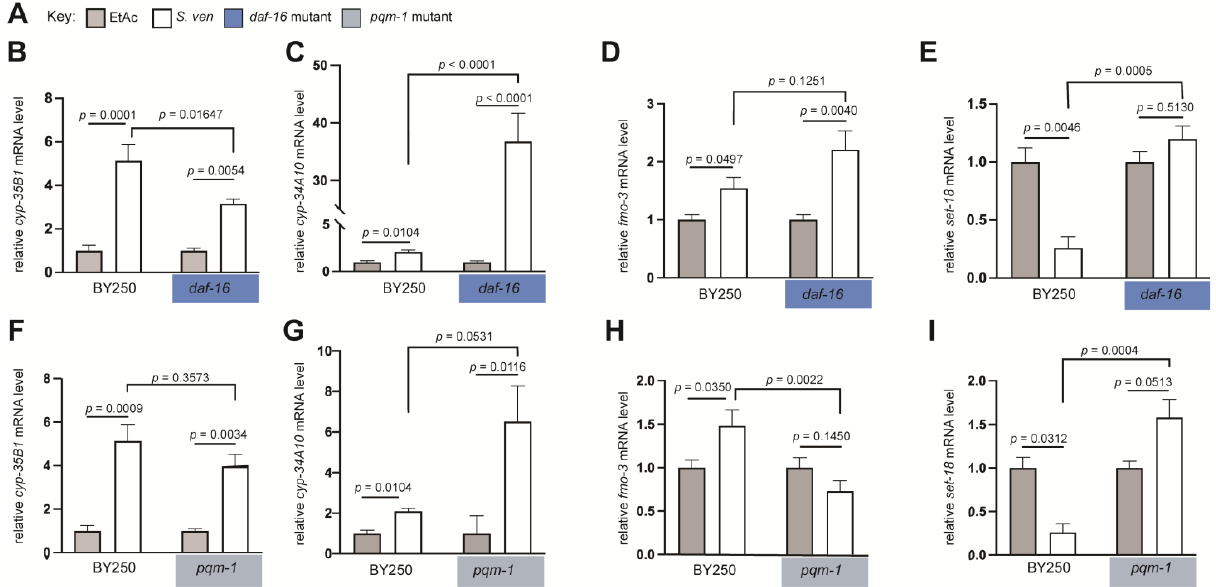
Figure 3. DEGs modulated by daf - 16 and pqm - 1 in response to S. ven metabolite. Quantification of relative mRNA expression levels of genes containing DAF-16 regulatory motifs was measured in daf - 16 (dark blue background) or pqm - 1 (light blue background) mutants following exposure to S. ven metabolite or EtAc treatments. ( A ) Key indicating gray bars represent EtAc exposure, and white bars represent S. ven exposure; dark blue boxes represent daf - 16 mutants and light blue boxes represent pqm - 1 mutants. ( B ) cyp - 35B1 mRNA expression was measured in day 7 BY250 and daf-16 mutant adult worms. ( C ) cyp - 34A10 mRNA expression was measured in day 7 BY250 and daf-16 mutant adult worms. ( D ) fmo - 3 mRNA expression was measured in day 7 BY250 and daf-16 mutant adult worms. ( E ) set - 18 mRNA expression was measured in day 7 BY250 and daf - 16 mutant adult worms. ( F ) cyp - 35B1 mRNA expression was measured in day 7 BY250 and pqm - 1 mutant adult worms. ( G ) cyp - 34A10 mRNA expression was measured in day 7 BY250 and pqm - 1 mutant adult worms. ( H ) fmo - 3 mRNA expression was measured in day 7 BY250 and pqm - 1 mutant adult worms. ( I ) set - 18 mRNA expression was measured in day 7 BY250 and pqm - 1 mutant adult worms. In all graphs, the normalized mean fold change of all biological replicates is relative to the EtAc control for each strain. Values represent mean +/ − SEM of 3–4 biological replicates with three technical replicates; at least 100 animals were used for each replicate. Significance was obtained via two-way ANOVA with Tukey’s post hoc and is represented using exact p -values (n = 120 per replicate, N = 3–4 biological